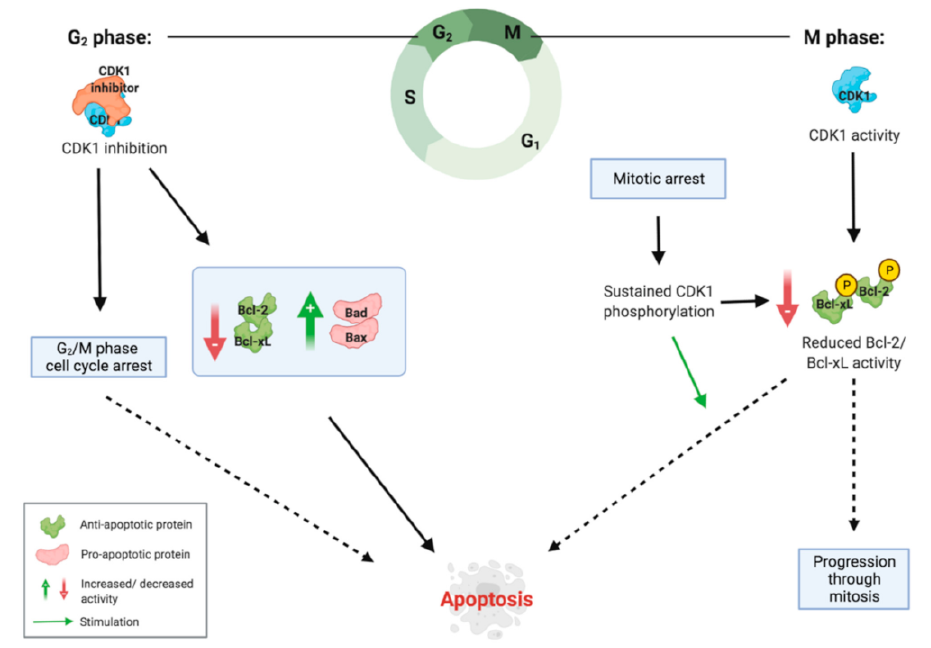
Figure 3. Role of CDK1 in apoptosis induction during the G2 and M phase. During the G2 phase, CDK1 inhibition leads to a decrease in anti-apoptotic proteins and an increase in pro-apoptotic proteins, stimulating the intrinsic apoptotic pathway. Furthermore, lack of CDK1 activity induces G2/M phase cell cycle arrest, which can also lead to apoptosis. During the M phase, CDK1 activity phosphorylates anti-apoptotic proteins in low amounts, inactivating them. In the situation of mitotic arrest, this phosphorylation is sustained, reaching high enough levels of inactivated anti-apoptotic proteins to induce